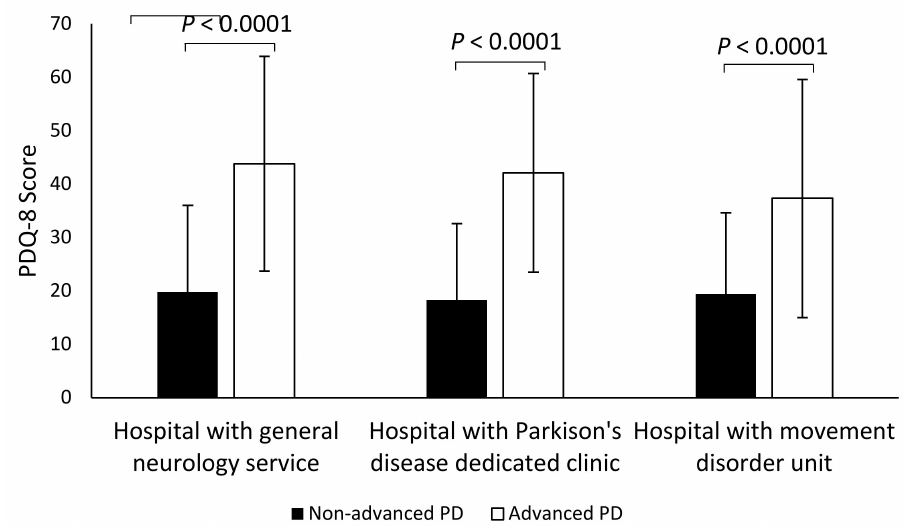
Figure 2. Quality of life of patients with advanced PD and non-advanced PD according to hospital type. PD, Parkinson’s disease; PDQ-8, 8-item Parkinson’s disease quality of life questionnaire. Bars represent mean ±